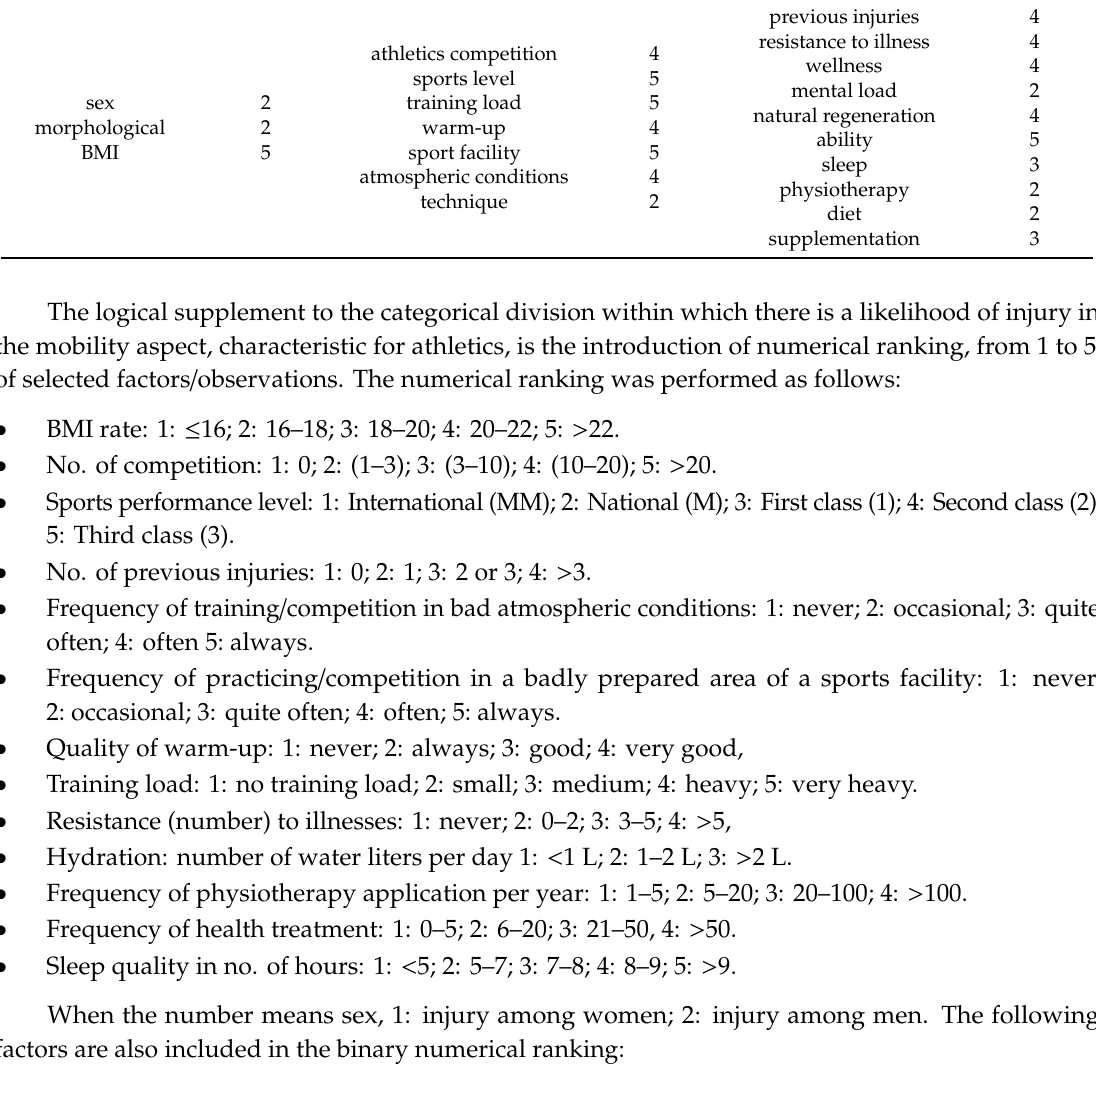
Table 1. Names of categorical predictors divided into numerical ranking (categories and their amount). Numerical Numerical Numerical Section / Predictors Section / Predictors Section / Predictors Ranking Ranking Ranking Demographic Training / Competition Health /